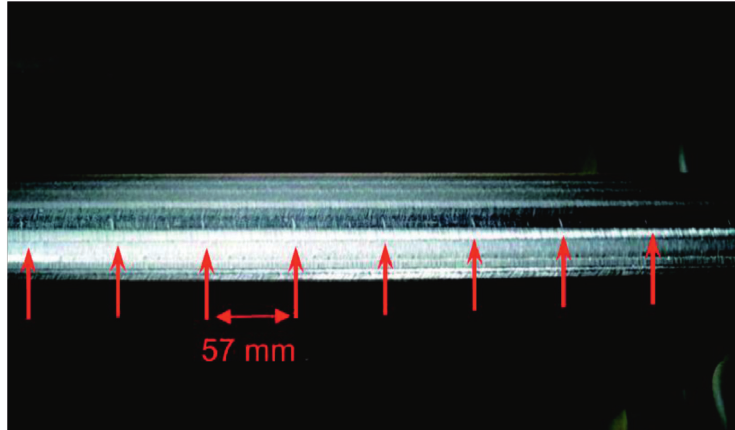
Figure 8: Grinding marks after rail grinding.